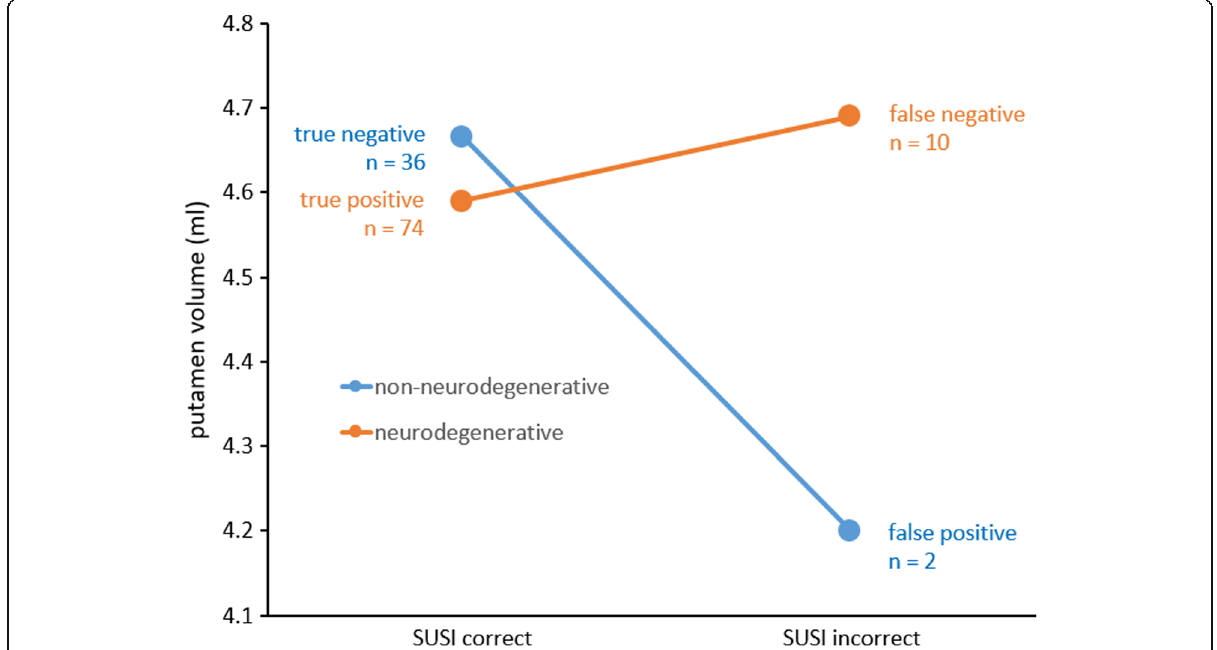
Fig. 4 Comparison of individual putamen volume between true positive and false negative cases and between true negative and false positive cases as classified by the SUSI computed in patient space. None of the differences reached statistical